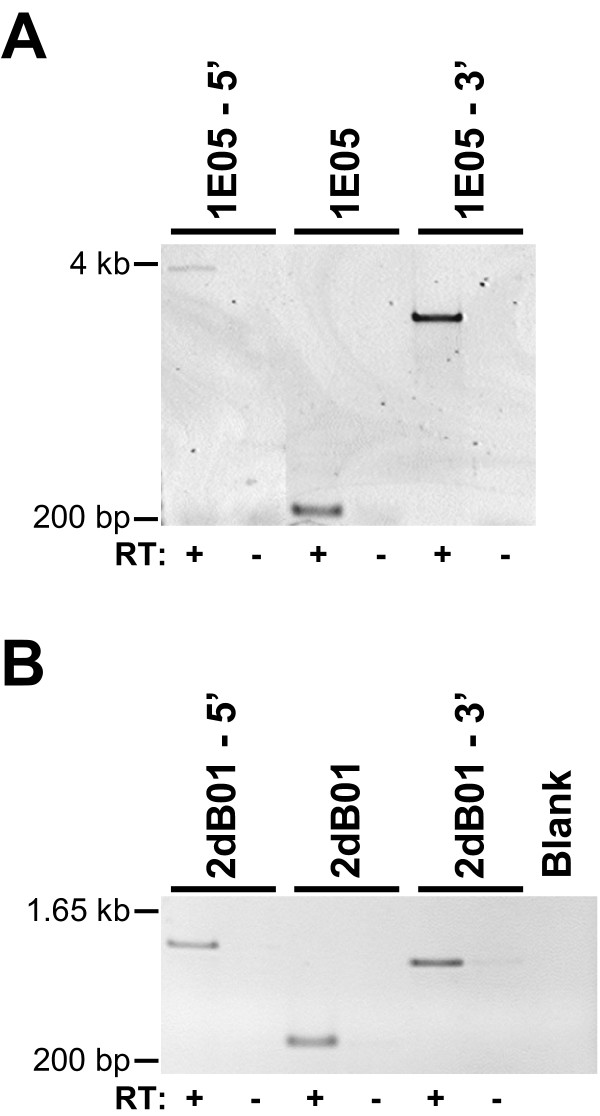
Two of the novel clones were part of transcripts containing a neighbouring SAGE tag. RT-PCR amplified transcript regions between clones 1E05 (A) and 2dB01 (B) and SAGE tags identified nearby each clone. RT indicates the presence or absence of Reverse Transcriptase.